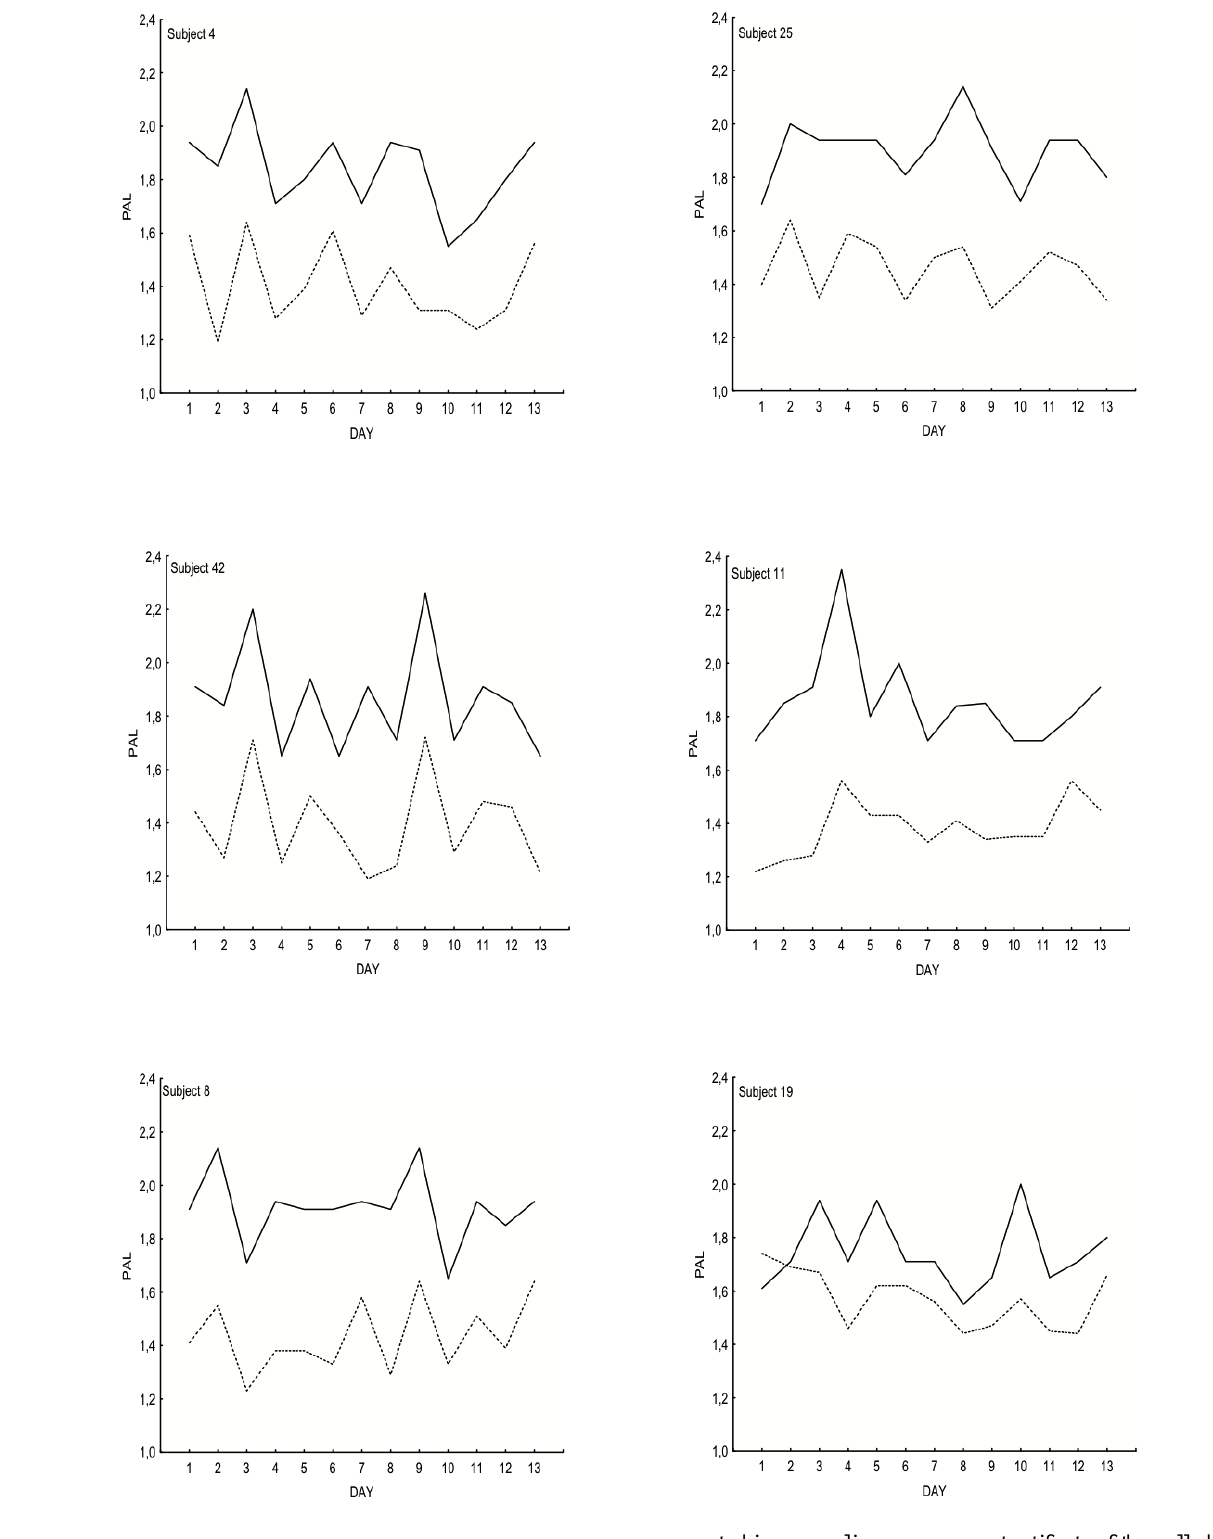
Figure 1. Daily measures of PAL over a 13-day period for 6 randomly chosen individuals (the dotted line indicates accelerometer data and the straight line indicates PAL data from cell